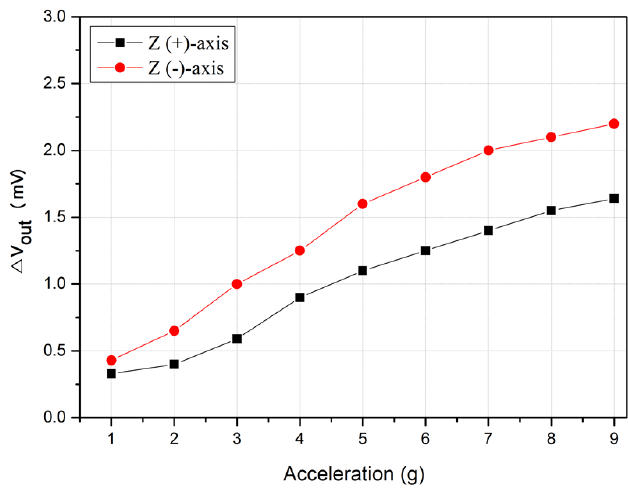
Figure 14. Output characteristic of the accelerometer on the Z-axis.